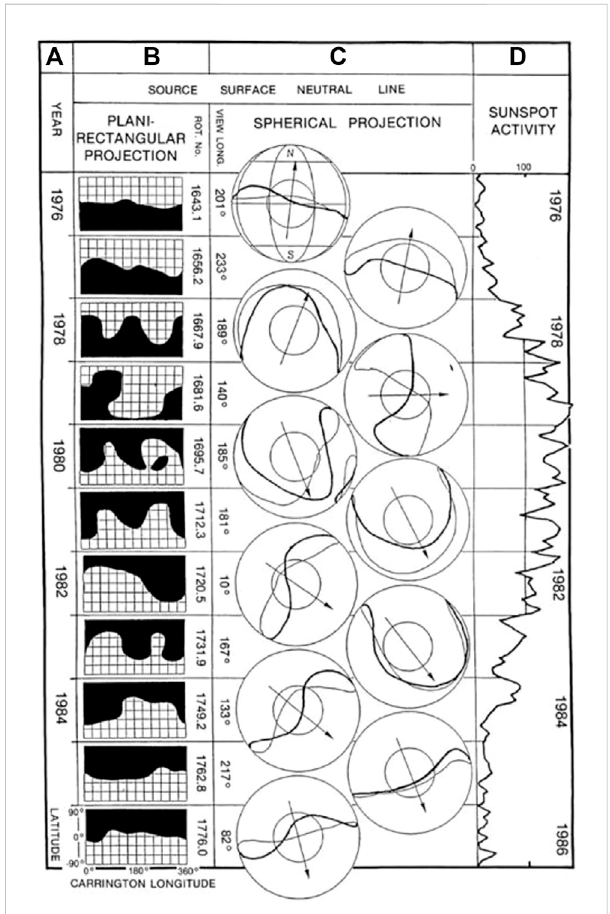
FIGURE 3 From the left: The neutral line dividing the positive and negative magnetic hemispheres on the source surface of the Carrington (2-D) map (WSO); Middle, the magnetic equator on the source surface (a 3- D format), together with the equivalent dipole axis based on the magnetic equator. Right; the sunspot number; Saito et al. (1989).